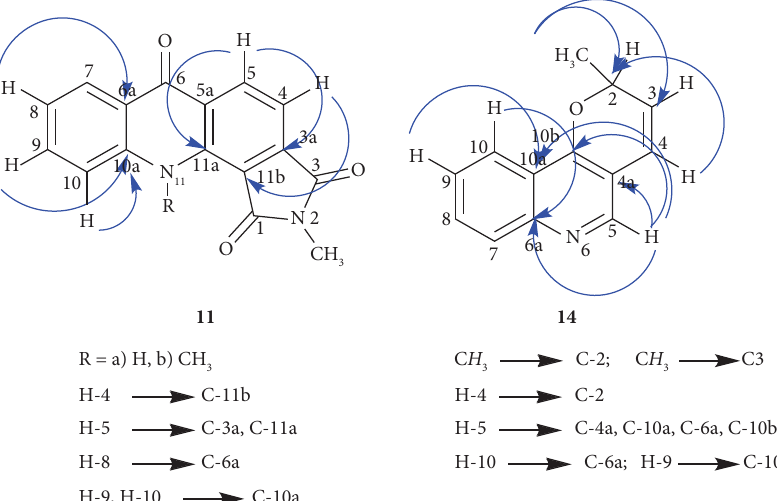
Figure 5: Structures and important correlations observed in the HMBC spectra of compounds 11a , b and 14 .